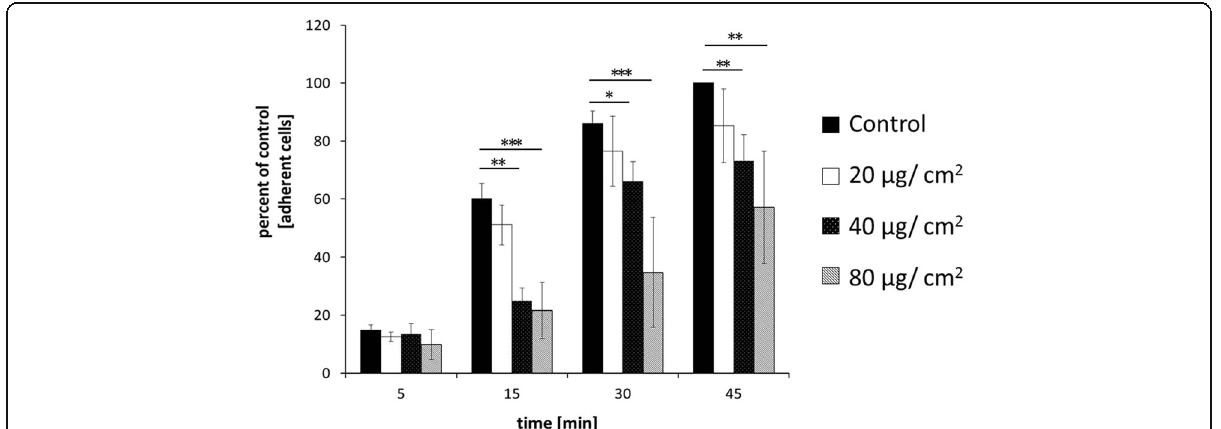
Fig. 1 Cell adhesion in VFFs is altered by SPIONs in a dose-dependent manner. No significant changes were detected at first 5 min and when VFFs are treated with SPIONs up to 20 μ g/cm 2 . Treatment with 40 and 80 μ g/cm 2 SPIONs resulted in significant decrease in VFF adhesion starting at 15 min. p values are indicated as * p ≤ 0.05, ** p ≤ 0.001, *** p ≤